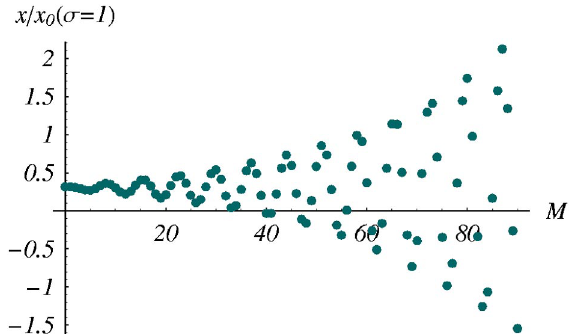
FIG. 5. (Color) Normalized lateral displacement of a finite train of pointlike bunches at the exit of a representative linear collider. See Table I for the choice